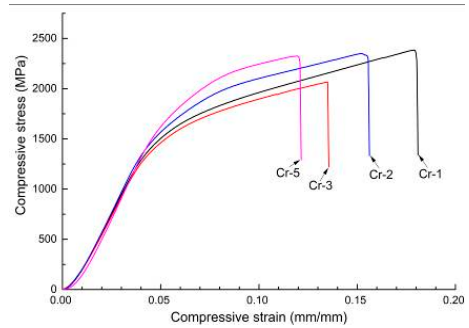
Figure 6. Stress–strain curves of alloys doped with Cr.